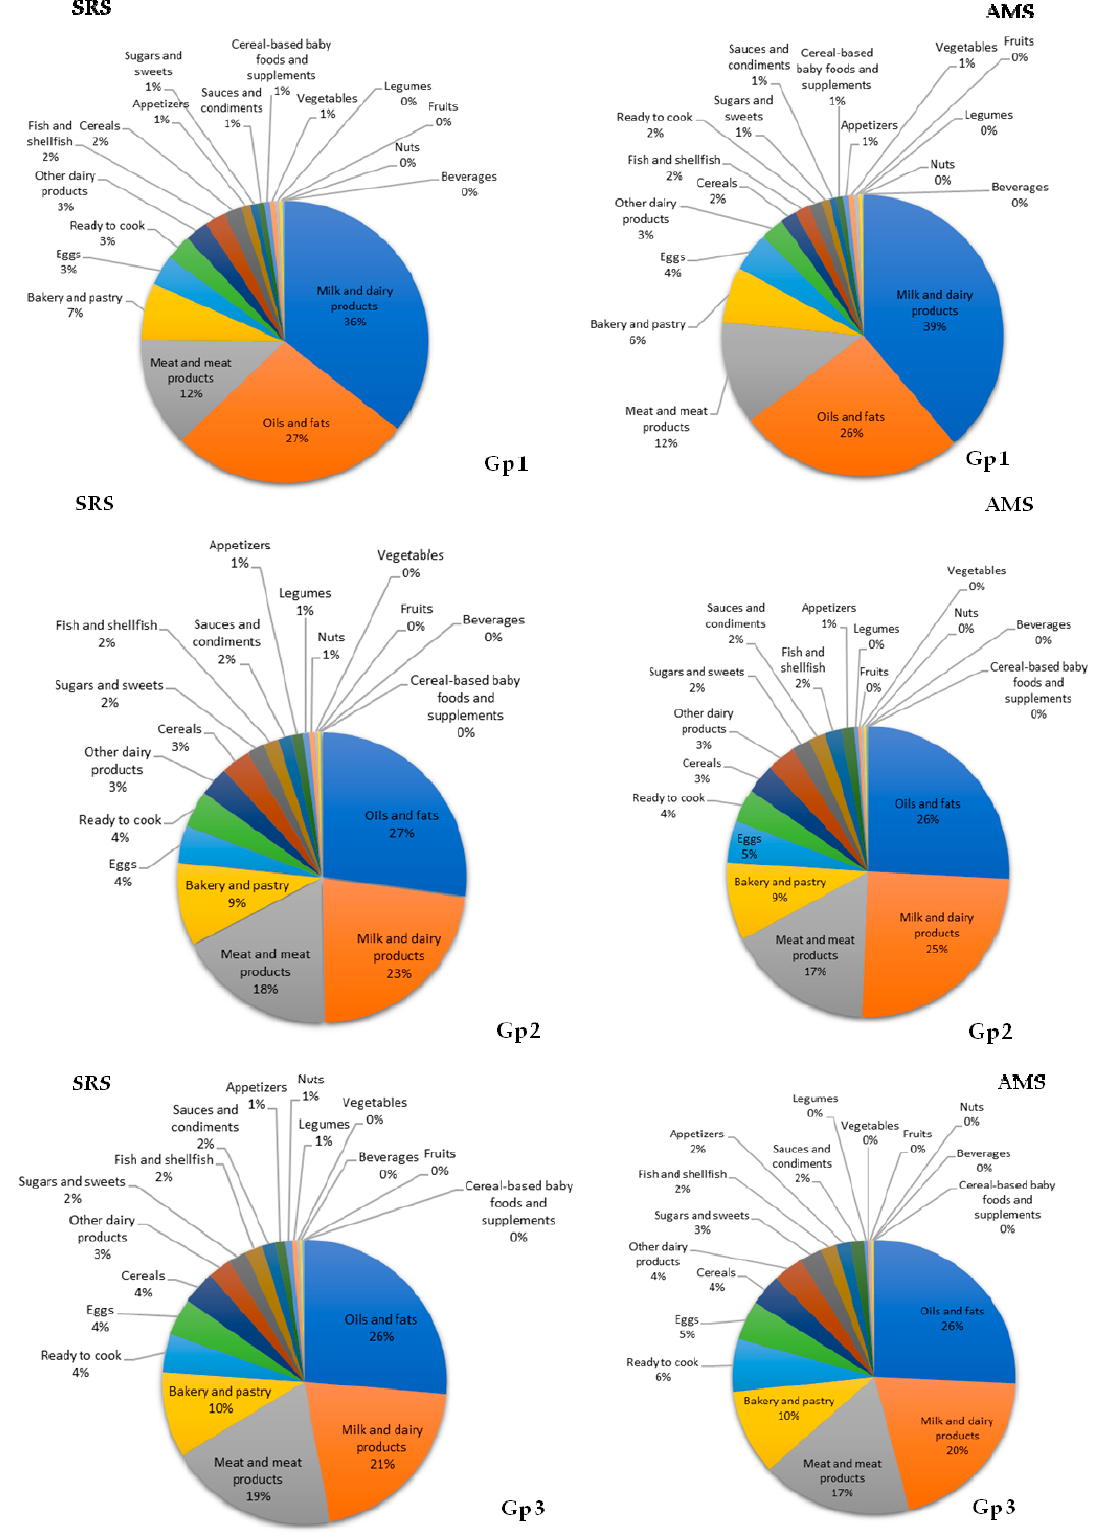
Figure 1. Contribution (%) of the 18 food groups to total fat intake in the EsNuPI study population (Spanish Reference Cohort (SRS) and Adapted Milk Consumers Cohort (AMS)) according to age group ( Gp 1 0 1 to < 3 years; ( Gp 2 ), 3 to < 6 years; ( Gp 3 ) 6 to < 10